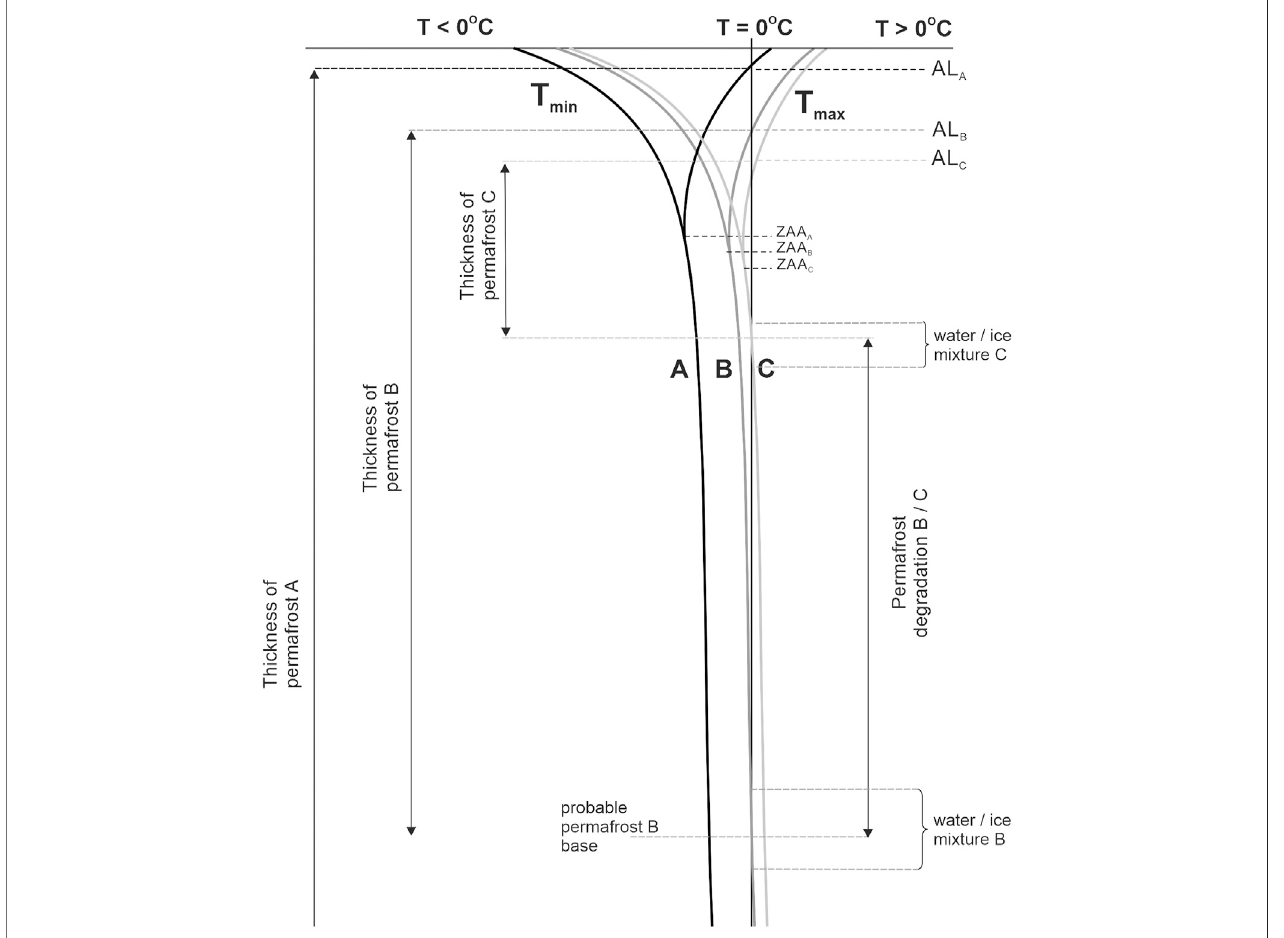
FIGURE 4 | Mode of degradation of thick isothermal warm permafrost, general view. Thermal degradation dominates between permafrost pro fi les (A,B) , physical degradation (thawing, and melting of ice) occurs between permafrost pro fi les (B,C) . Compare difference between amount of degradation between AL and permafrost